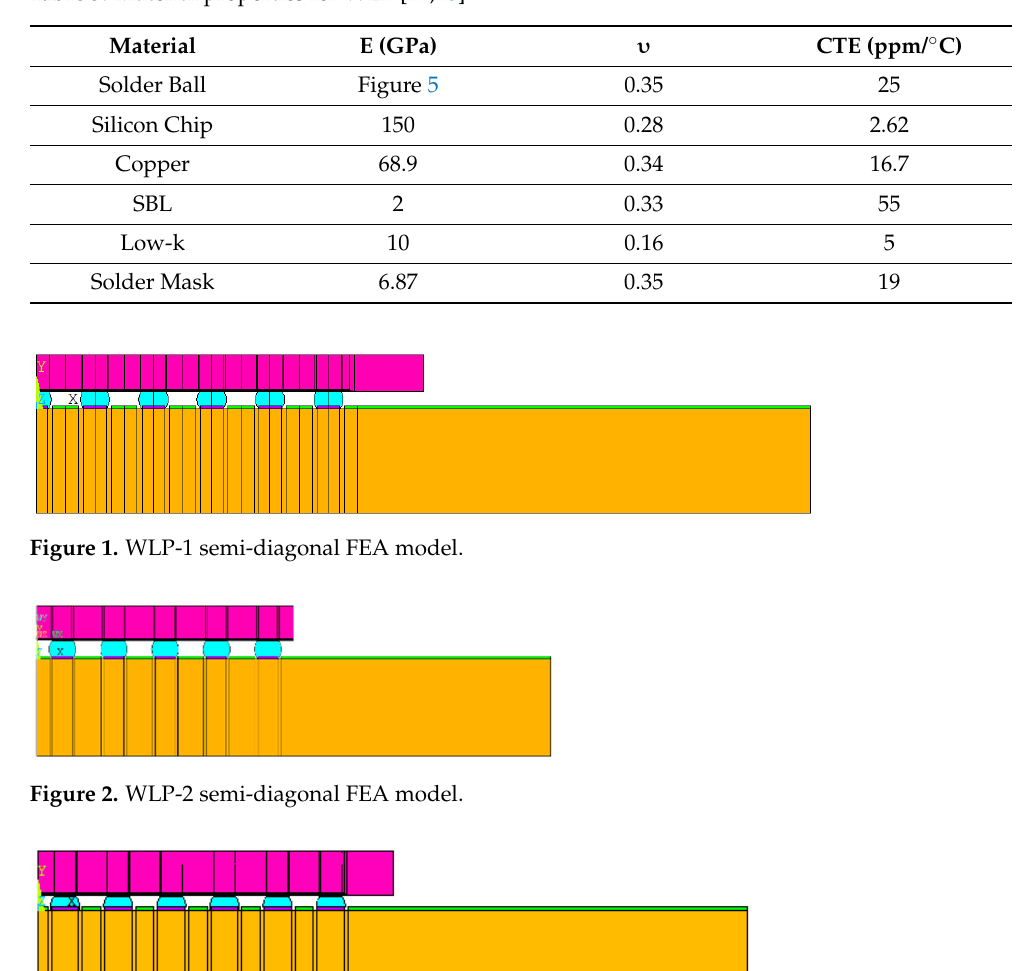
Table 3. Material properties for WLP [17,18].